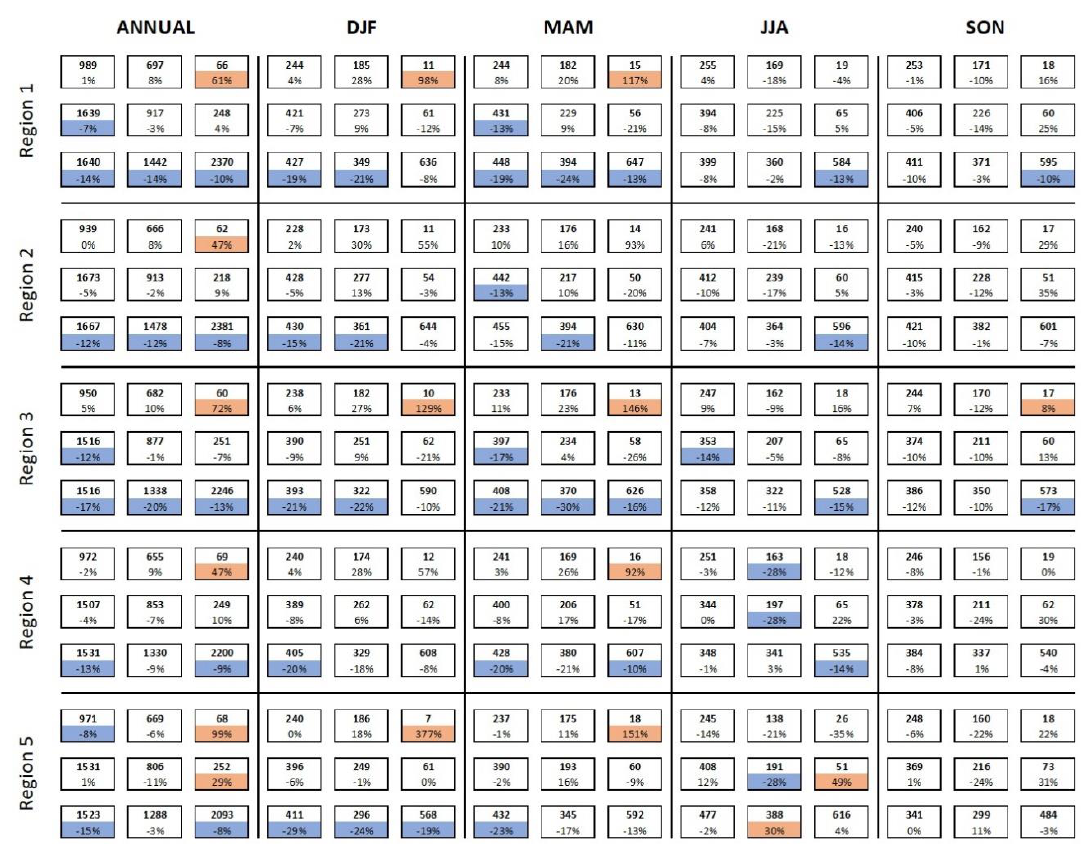
Figure 21. The number of events of the wind shear intensity between 0 and 6 km for each type of event, region and season. For the historical climate (1st line of the cell) and the difference between the future and historical (2nd line of the cell). Shaded values indicate significant differences (t-student 5%) positive (red) and negative (blue).